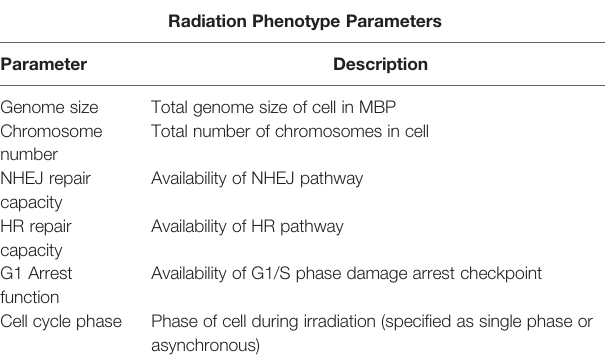
TABLE 1 | List of cell-speci fi c features which de fi ne the minimal radiation phenotype used to predict the sensitivity of cells in this model.